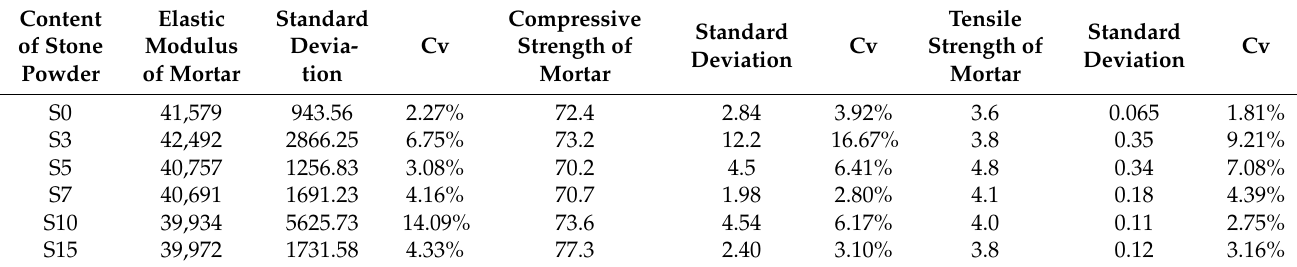
Table 7. Mechanical parameters of cement mortar